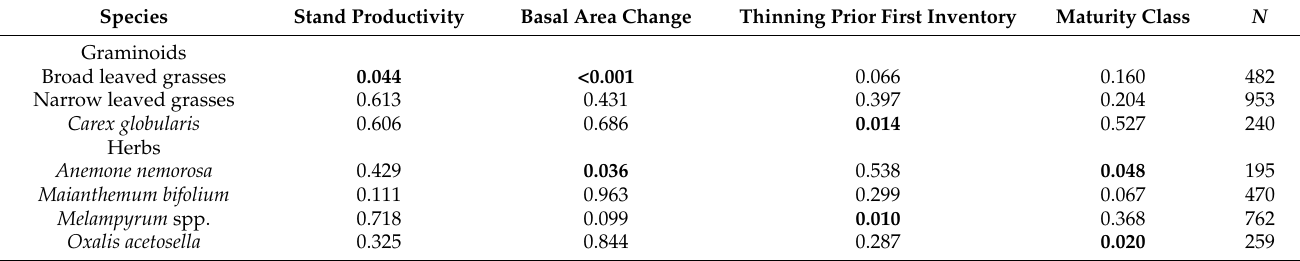
Table A1. Effects of stand productivity, basal area change, presence of thinning 10 years prior to first inventory period and stand Maturity class (see Table 1) on the change in cover during the studied 10-year period. Values are p -values from linear models with regions treated as a block in the analysis. Bold numbers indicate a significant effect. N denotes number of plots where the species